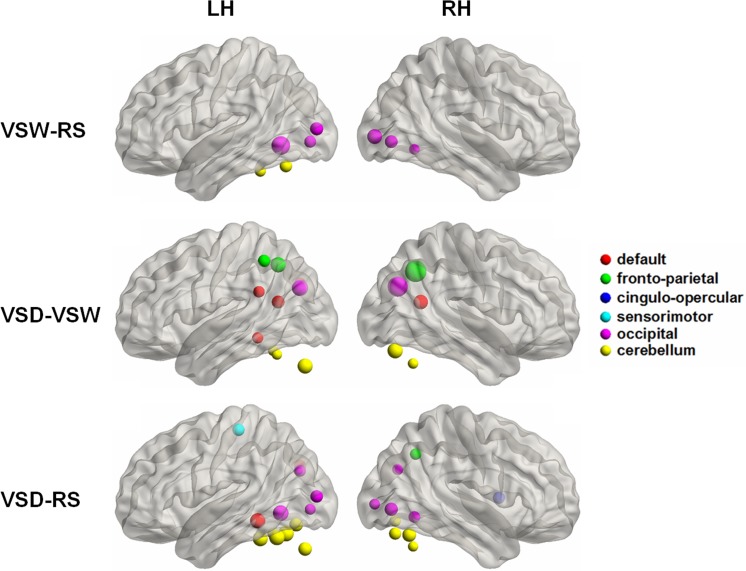
Surface visualization of the brain regions exhibiting significant between-state differences in nodal efficiency for the three comparisons, VSW-RS, VSD-VSW, and VSD-RS.The node size is proportional to the relative significance of each between-state comparison (two-tailed paired t-test, p < 0.05, FDR correction). The node colors indicate the node belonging to the six different modules according to the brain template [35]. Uniformly, we detected significantly increased nodal efficiency between each of the three comparisons, VSW-RS, VSD-VSW, and VSD-RS. RS: resting-state, VSW: visual stimulus watching task, VSD: visual stimulus decision task. LH (RH), left (right) hemisphere.